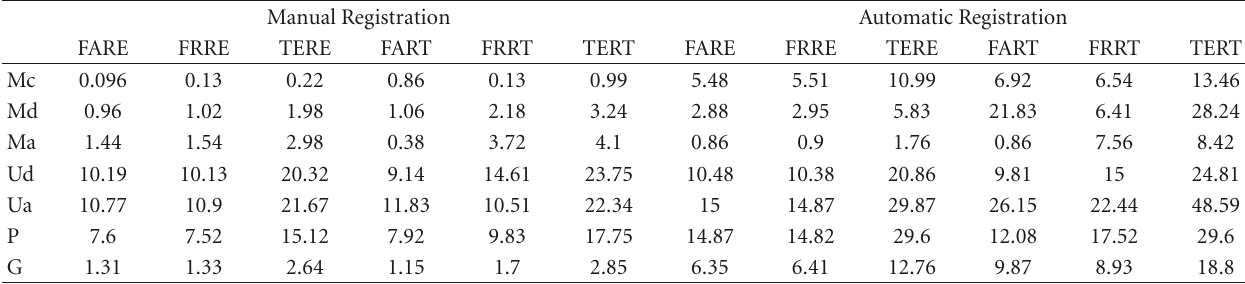
Table 5: Fusion results on BANCA protocols with PCA and LDA space using SVM, manual registration (left), and automatic registration